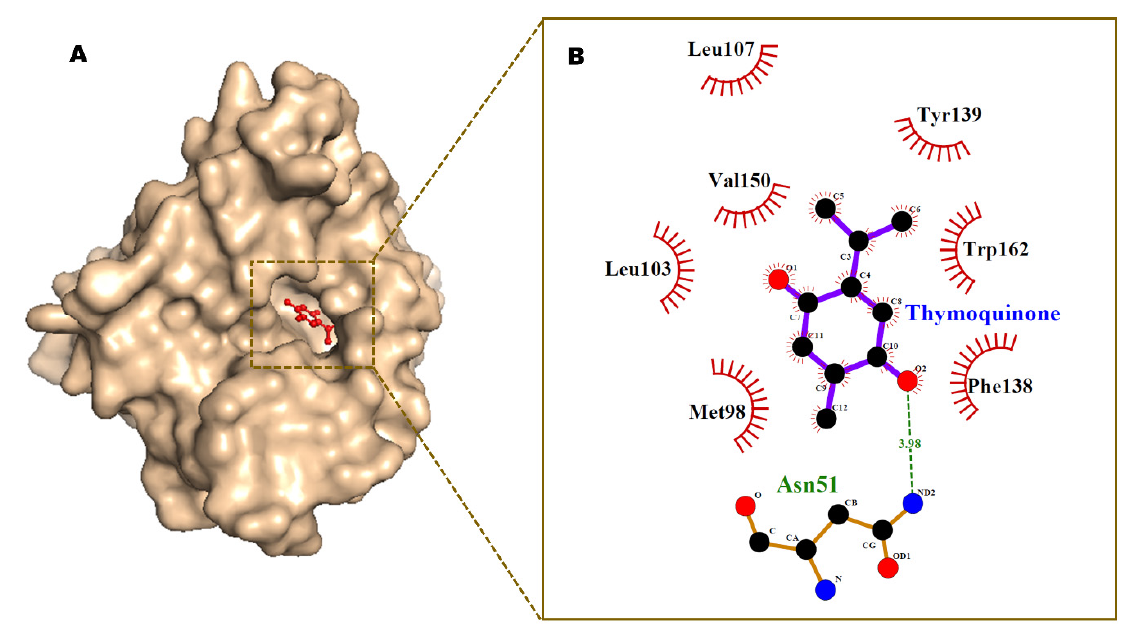
Figure 2. Minimum energy conformation of the docked TQ in the inhibitor binding cavity of Hsp90 protein shown as surface ( A ). Ligplot diagram ( B ) showing intermolecular interactions. Hydrogen bond interaction is shown as a broken green line.